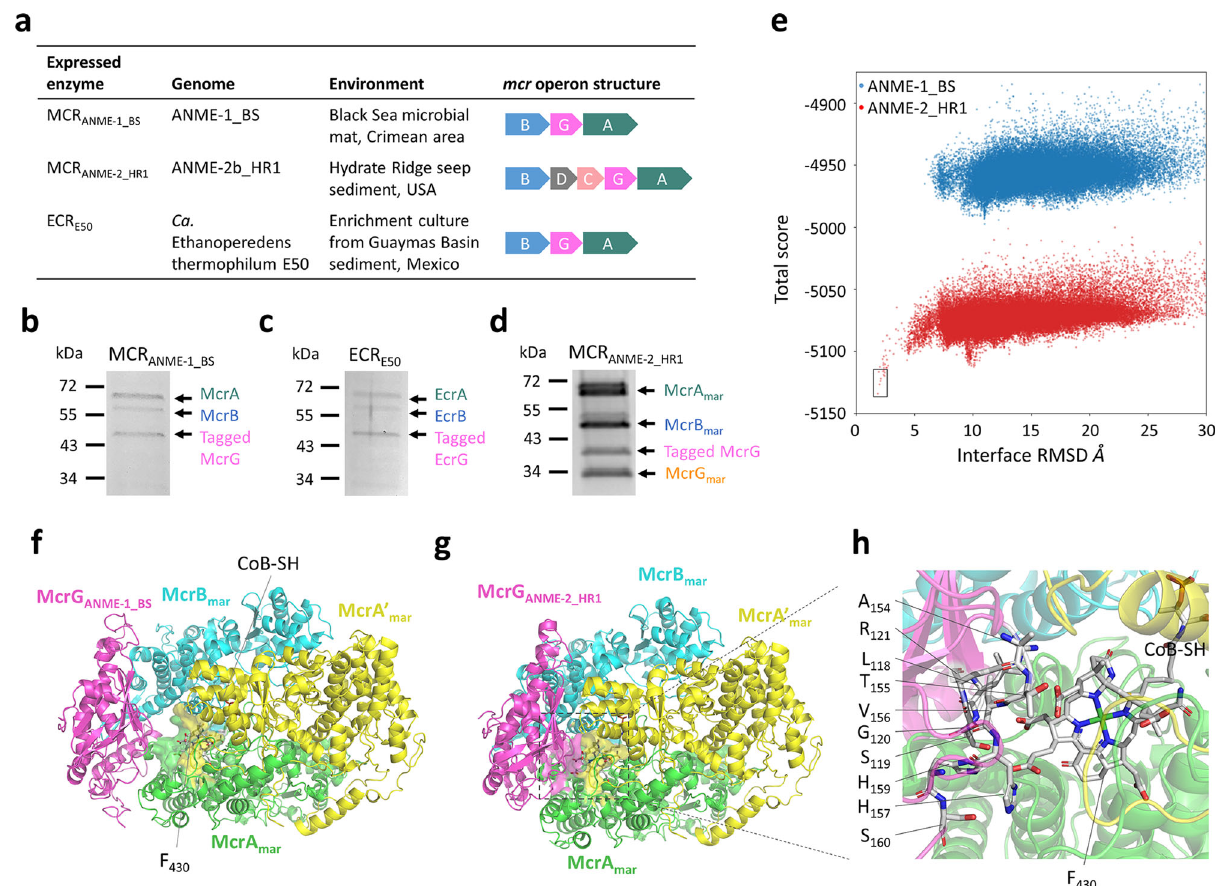
Fig. 6 ANME MCRs and an ECR expressed in M. maripaludis . a General information and operon structures of MCR ANME-1_BS , MCR ANME-2b_HR1 , and ECR E50 . b – d SDS-PAGE analysis of the puri fi ed MCR ANME-1_BS , ECR E50 , and MCR ANME-2_HR1 produced from M. maripaludis grown at 25 o C. The molecular weights based on standards are labeled on the left. Protein identities (labeled on the right) were con fi rmed by MALDI-TOF MS. The tagged McrG ANME-2_HR1 co- puri fi ed with the host MCR mar . e Total score (Rosetta energy unit; REU) vs. I_rmsd plot for local docking simulations of McrG ANME-1_BS (blue) and McrG ANME-2_HR1 (red) to the M. maripaludis McrA, B, G complex. The plot displays 60,000 scoring models. The best model obtained from the McrG ANME- 1_BS docking had a 5.869 Å I_rmsd and a -4965.008 total score. The best model obtained from the McrG ANME-2_HR1 docking had a 1.848 Å I_rmsd and a -5133.935 total score. The ten lowest-energy scores with I_rmsd < 2.5 Å are labeled in the black box. f , g Structural models with the smallest I_rmsd in the simulation of the McrG ANME-1_BS (magenta, f ) and McrG ANME-2_HR1 (magenta, g ) docking to the M. maripaludis McrA (green), B (cyan), G (yellow) complex. The protein subunits are presented in cartoon, and F 430 and CoB-SH are depicted in stick models. Only one active site composed of the M. maripaludis McrA (green), A ’ (yellow), B (cyan), and the ANME McrG (magenta) subunits and one F 430 are shown for clarity. The amino acids within 8 Å surrounding F 430 are shown as surface representation. h The ten amino acids of McrG ANME-2_HR1 within 8 Å surrounding F 430 are labeled on the left and shown in